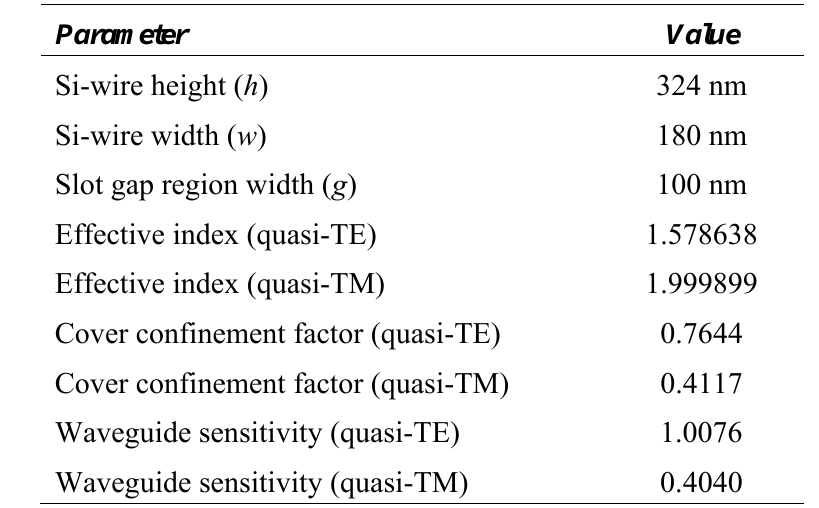
Table 1. Parameters of coupled slot waveguides (effective indices, confinement factors and sensitivities calculated by assuming an aqueous solution as cover